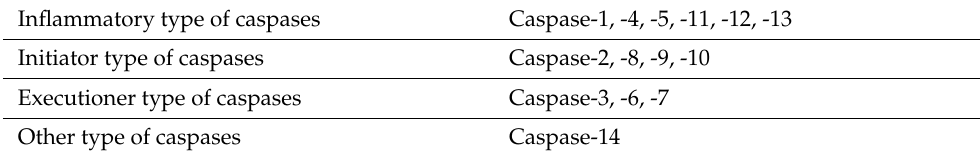
Table 2. Division of